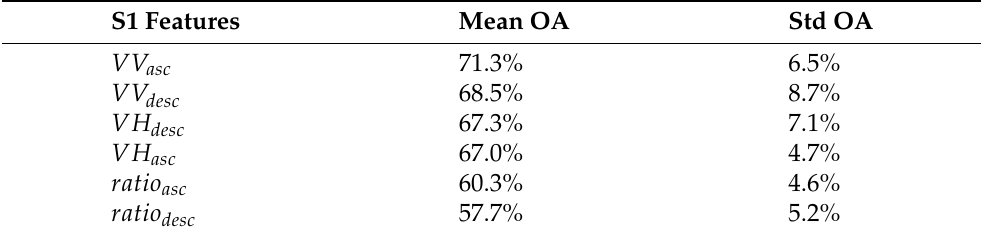
Table 3. Classification algorithm calibration results with the Sentinel-1 features. For each feature time series, the mean overall accuracy (mean OA) and its standard deviation (std OA) over the 4 iterations of the cross-validation scheme are given.